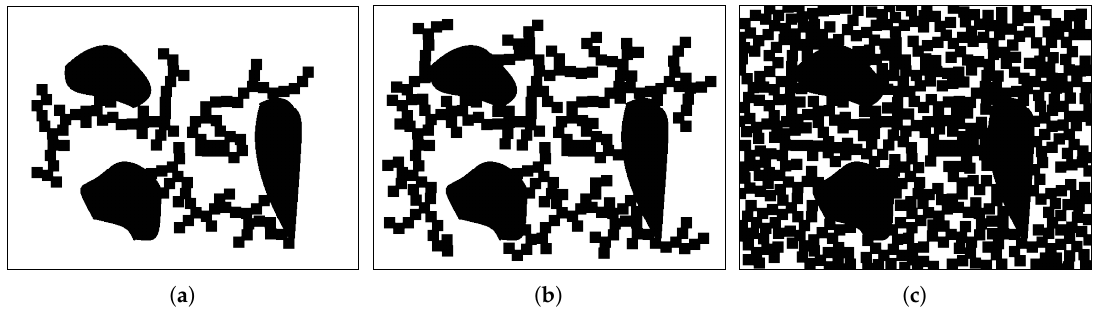
Figure 12. The nutrients of the map. ( a ) The 100th step. ( b ) The 200th step. ( c ) The final step.